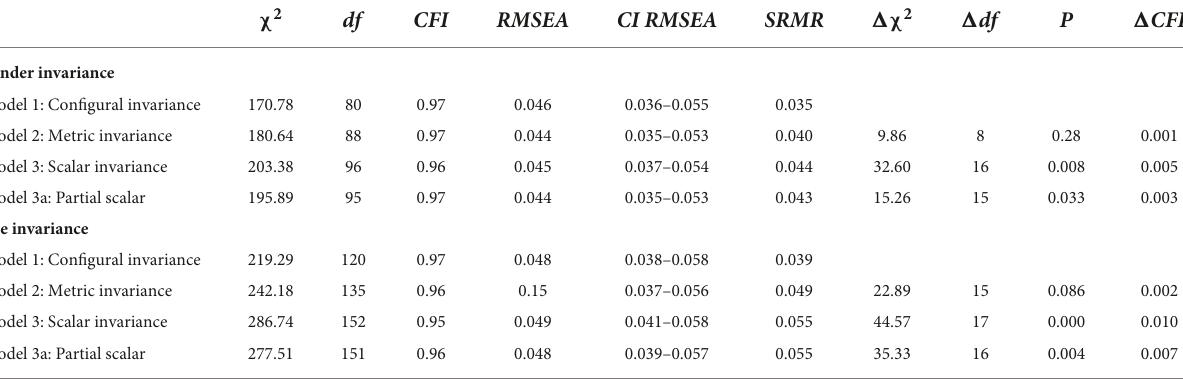
TABLE 2 Fit indices for gender and age invariance of self-efficacy in managing positive emotions. χ 2 df CFI RMSEA